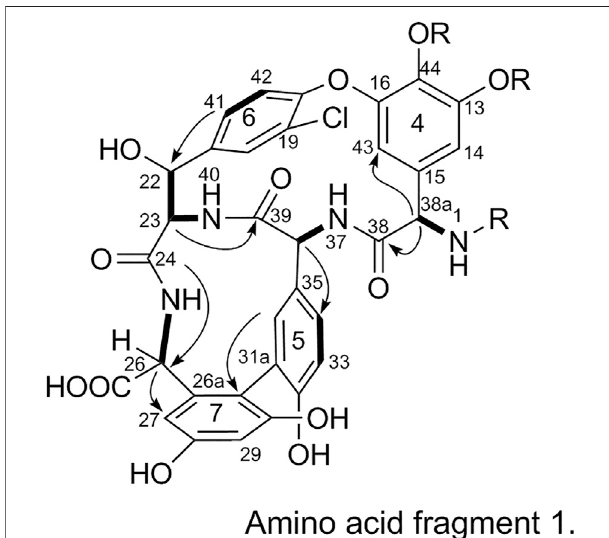
FIGURE 5 | Structure of 1 based on the HMBC and 1 H- 1 H COSY spectra.